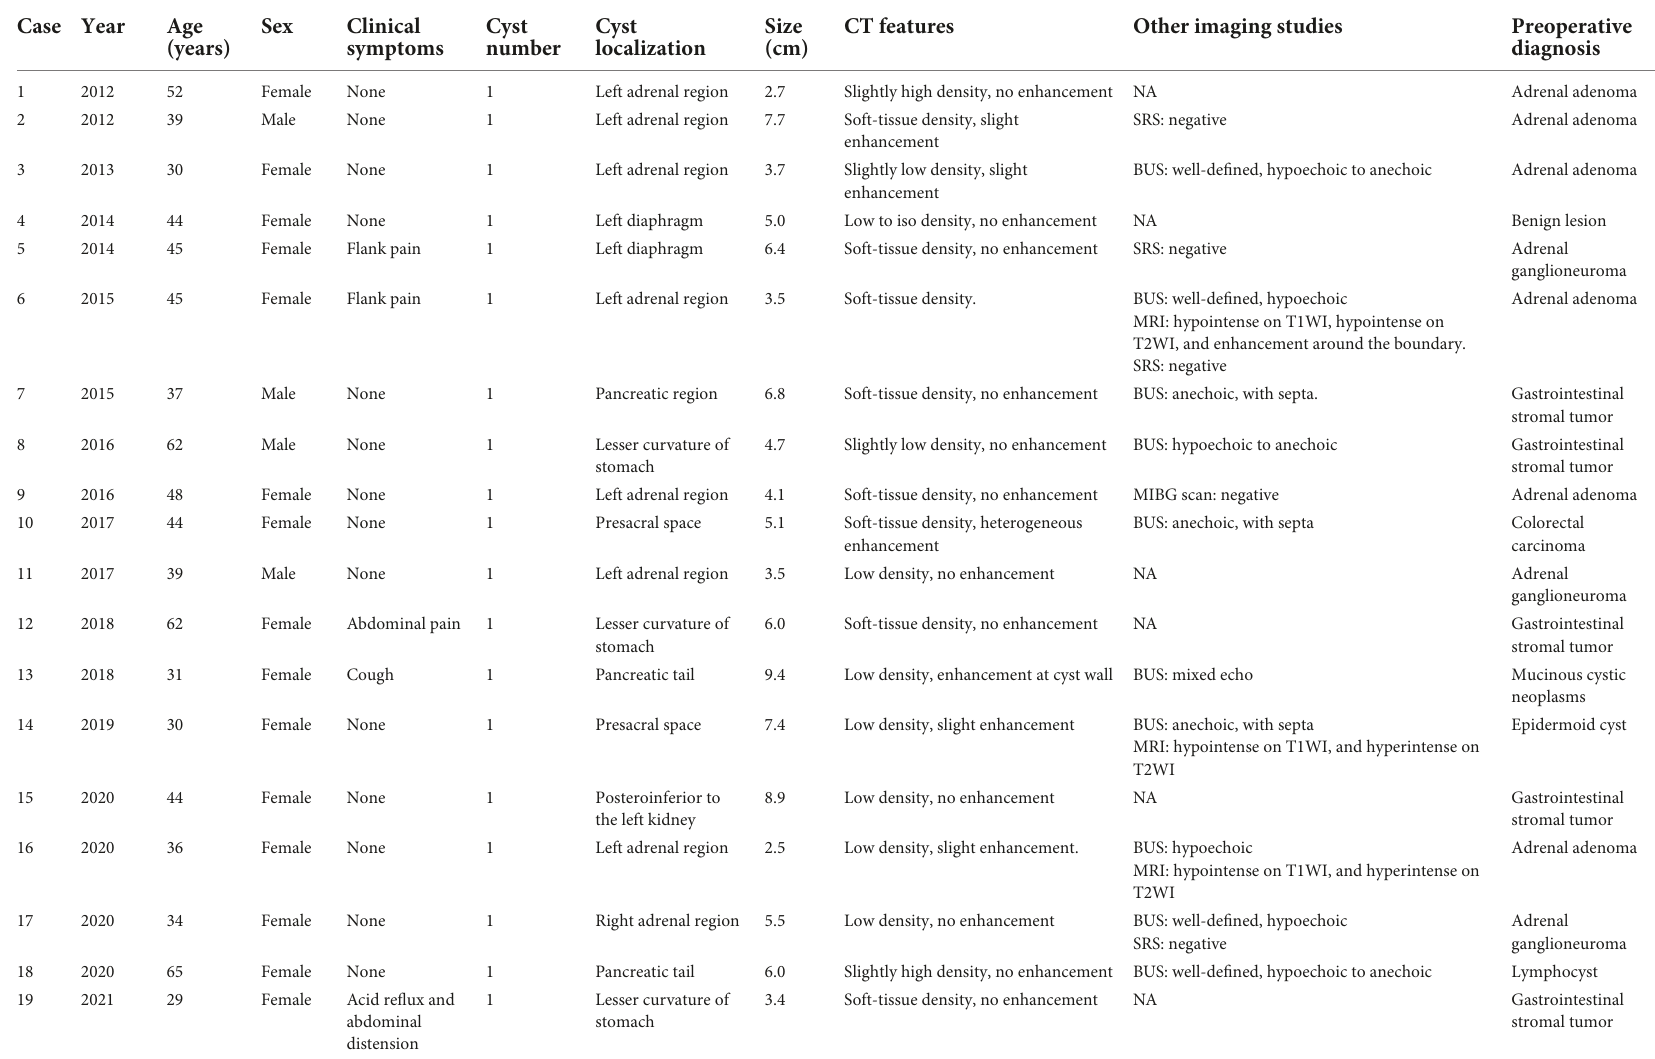
TABLE 1 Demographics, clinical symptoms, imaging features, and preoperative diagnosis of 19 patients with subdiaphragmatic bronchogenic cyst from our case series. Case